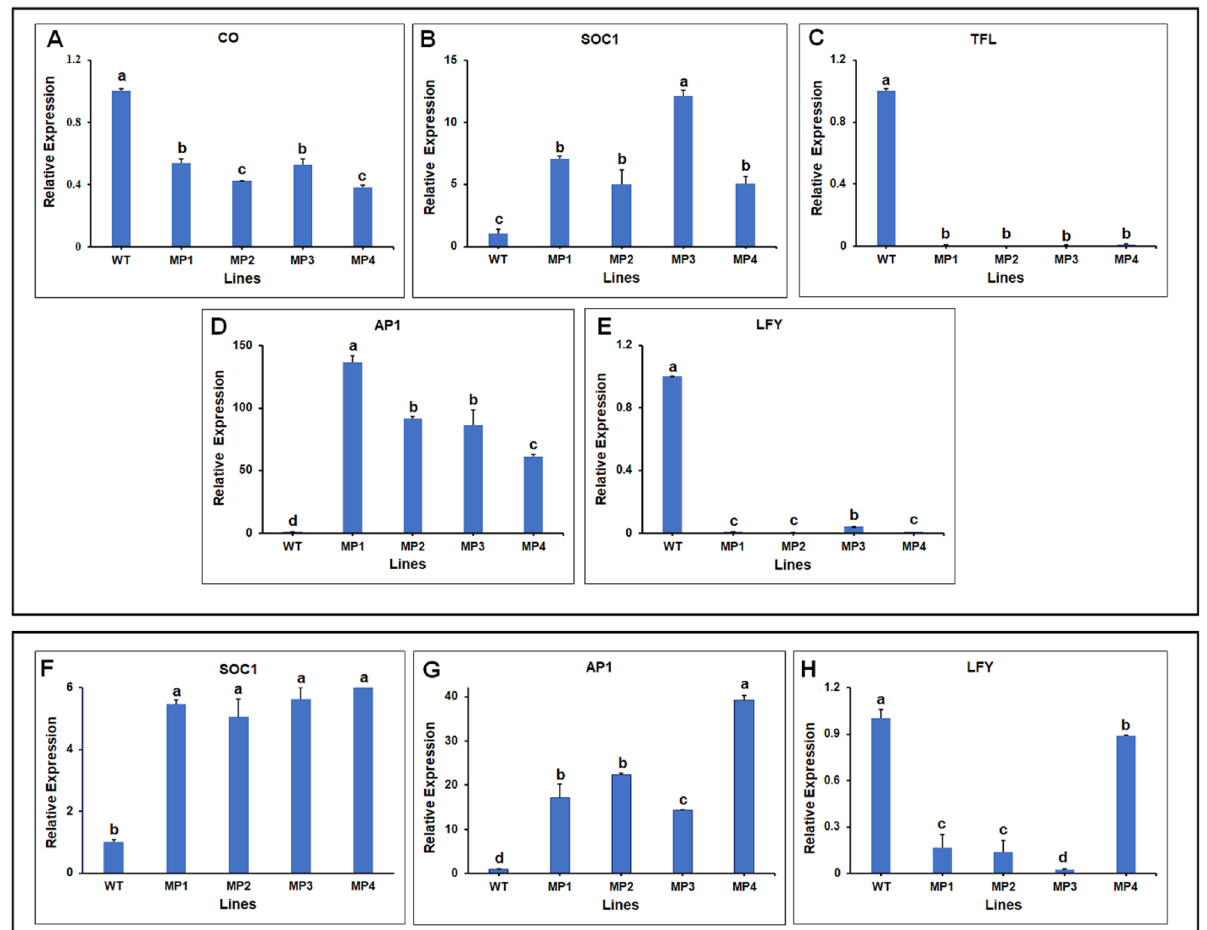
Figure 6. Evaluation of flowering pathway related genes. ( A – E ) Relative expression of flowering related genes for each of the 16-month old transgenic lines compared to the non-transgenic Carrizo citrange shown by RT-qPCR ( A ) CONSTANS ( CO ), ( B ) SUPPRESSOR OF OVEREXPRESSION OF CONSTANS 1 ( SOC1 ), ( C ) TERMINAL FLOWER1 ( TFL1 ), ( D ) APETALA1 ( AP1 ) and (E) LEAFY ( LFY ). RNA was extracted from leaf petioles rich in phloem tissues. ( F – H ) Total RNA was extracted from leaf tissues to show the expression flowering pathway genes by RT-qPCR ( A ) SOC1 , ( B ) AP1 and ( C ) LFY in the AtSUC2-CcFT3 transgenic lines compared to the Carrizo citrange non-transgenic line. CsACTIN was used as the reference gene. Data represent the mean (± standard deviation, SD) of three technical replicates. Different letters represent a significant difference at P < 0.05 using Student’s